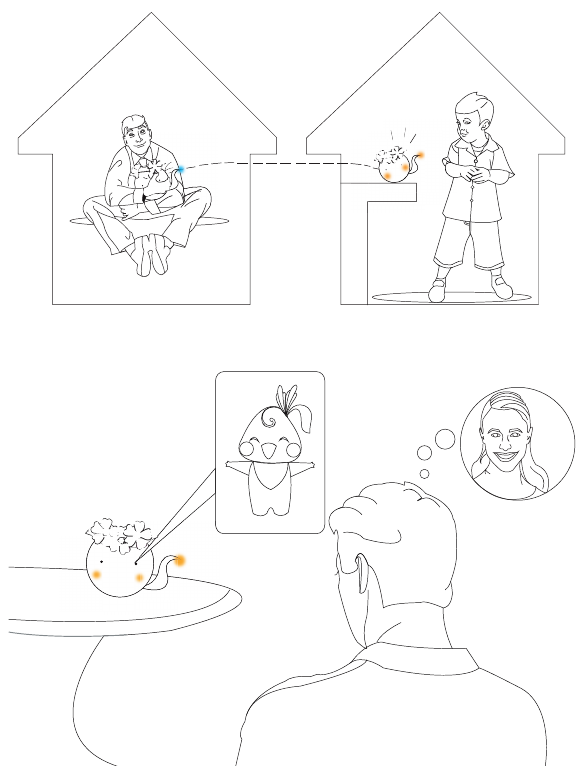
Figure 13. Social context for the proposed companion robot Pepita: ( Top ) as a tangible emoticon; ( Bottom ) as a presence